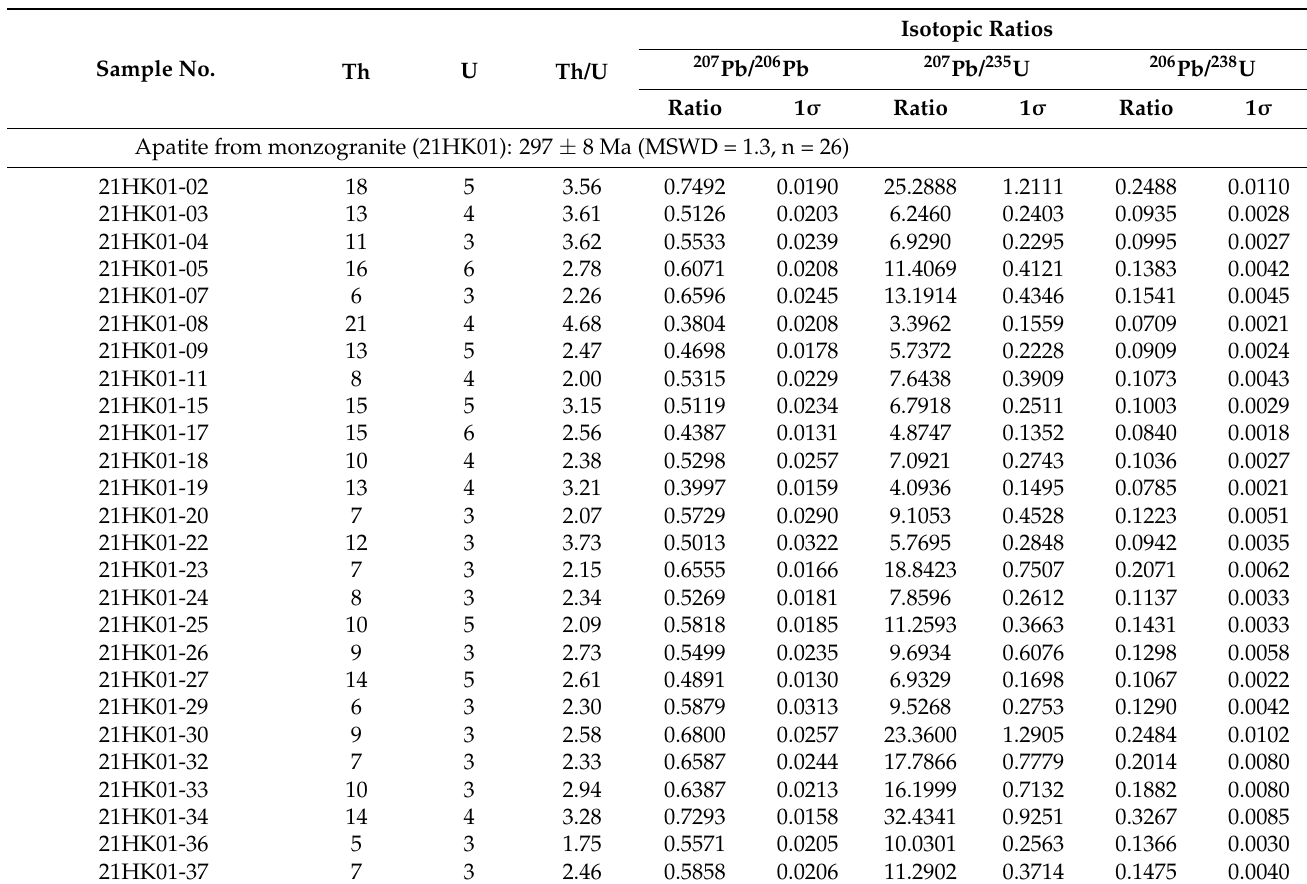
Figure 6. Chondrite-normalized REE + Sr multi-element plots ('spidergrams') of Muniushan apatite [63]. Table 1. LA–ICP–MS U-Pb apatite data from monzogranite (21HK01) at Houkuang.